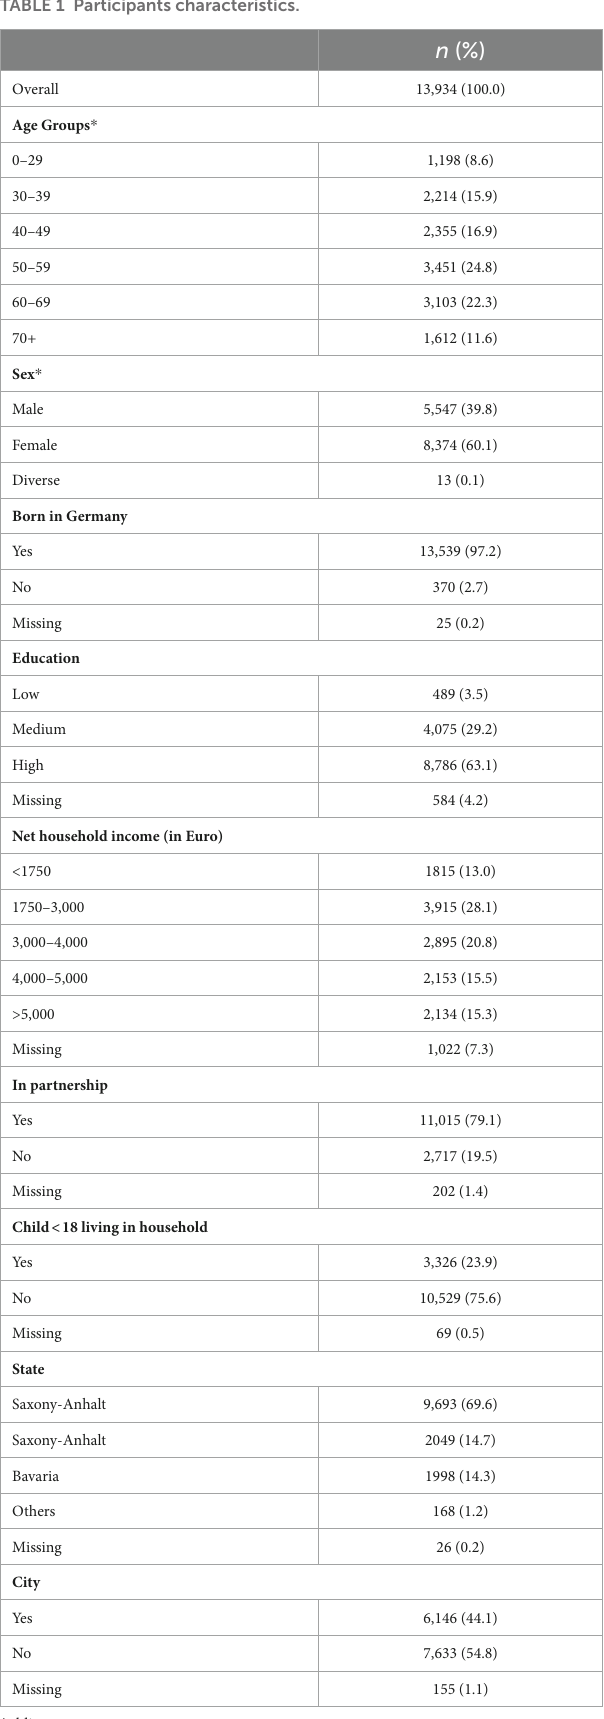
TABLE 1 Participants